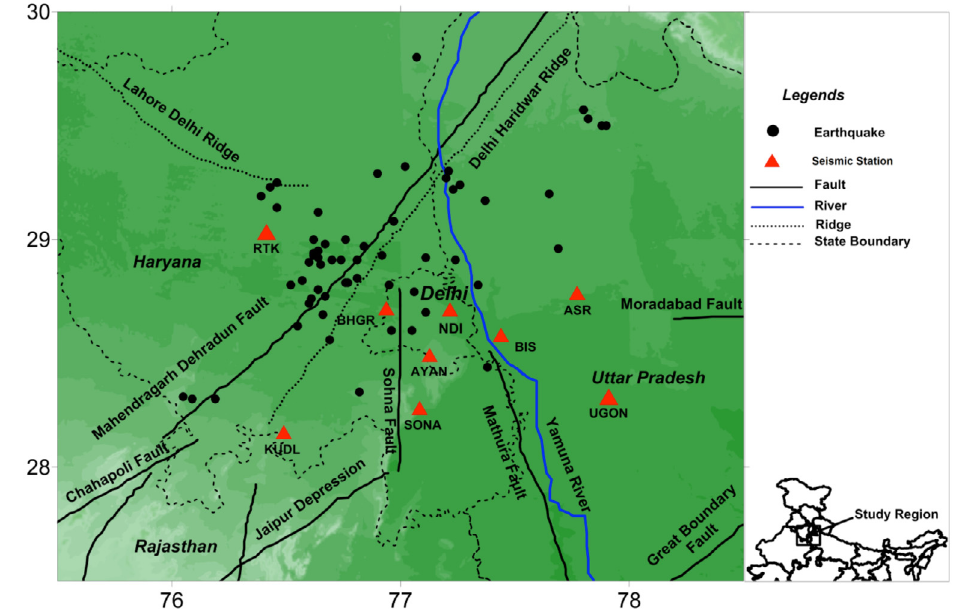
Figure 1. Epicentral locations of earthquake events and seismological stations in and around Delhi area.